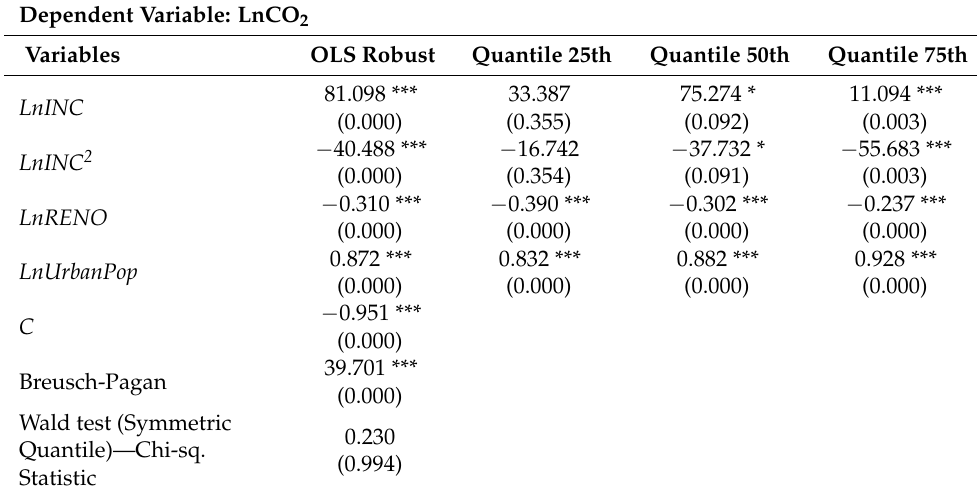
Table 9. Testing the impact of renewable energy on the Environmental Kuznets Curve with ordinary least squares (OLS) and Panel Quantile